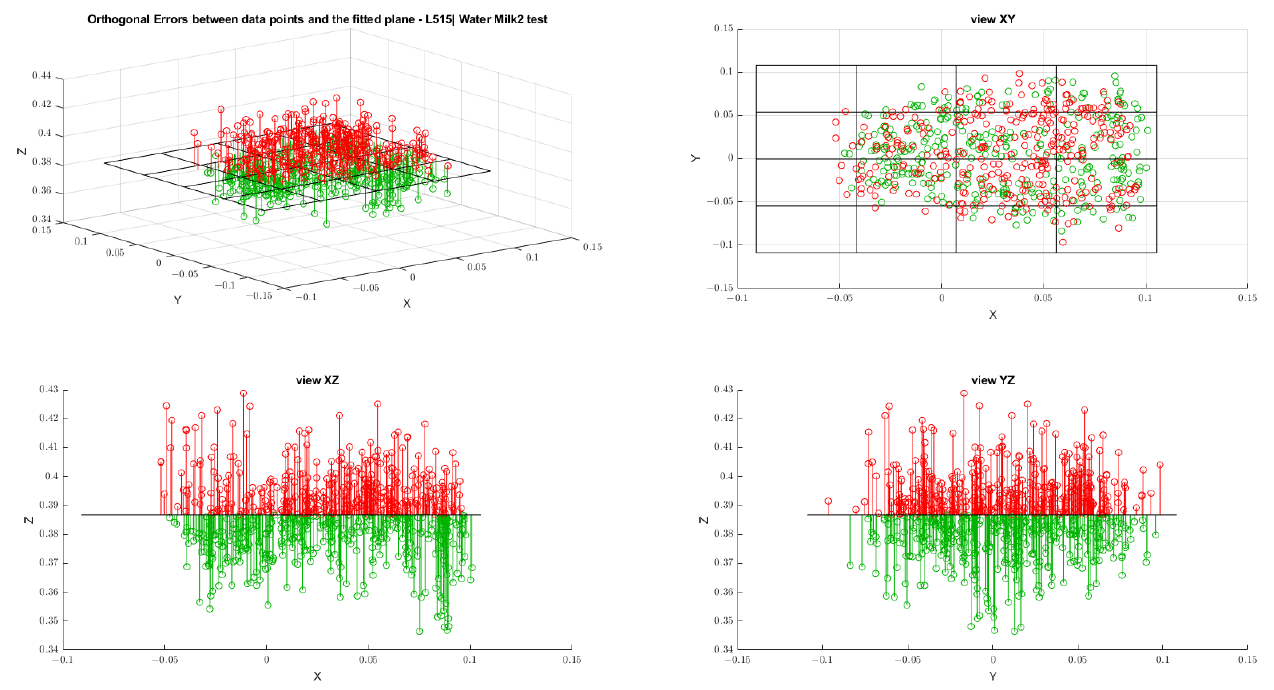
Figure A11. Results of orthogonal errors for the L515 camera referring to the water milk1 test.